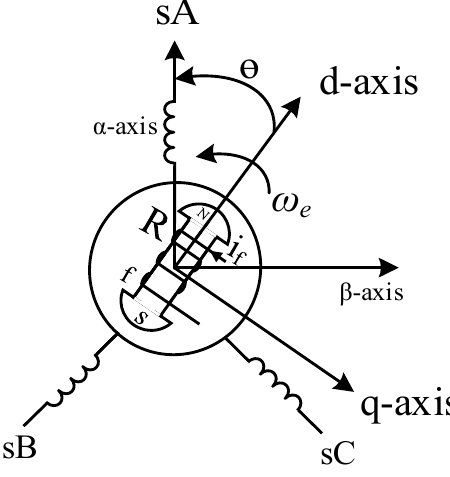
Figure 3. The dq -coordinate frame of the Figure 3. The 𝑑𝑞 -coordinate frame of the PMSG.